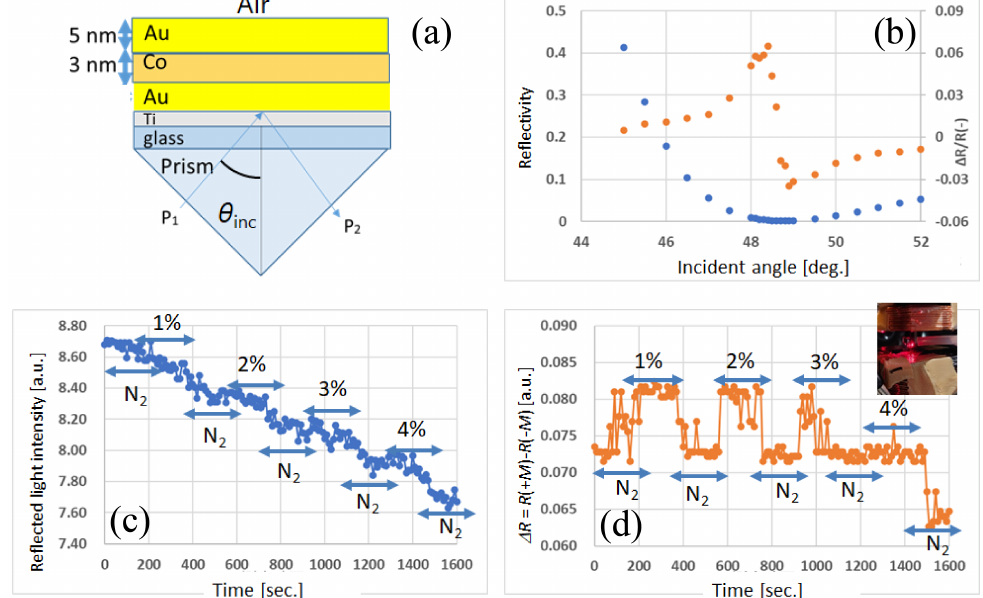
Figure 2. ( a ) A schematic diagram of the fabricated Au/Co/Au MOSPR sensor. A quartz glass prism is mounted on top of the glass substrate, and the light is coupled with an incident angle θ inc . ( b ) The reflectivity measured in air without magnetic field (left axis), and TMOKE = ∆ R / R (right axis). Time transient of ( c ) the reflected light intensity and ( d ) TMOKE upon ethanol gas injection at concentrations of 1, 2, 3, and 4%. In the inset is a photo of the MOSPR sensor chip that was mounted on a quartz prism and positioned between a pair of coils. This chip was part of the Au/Co/Au